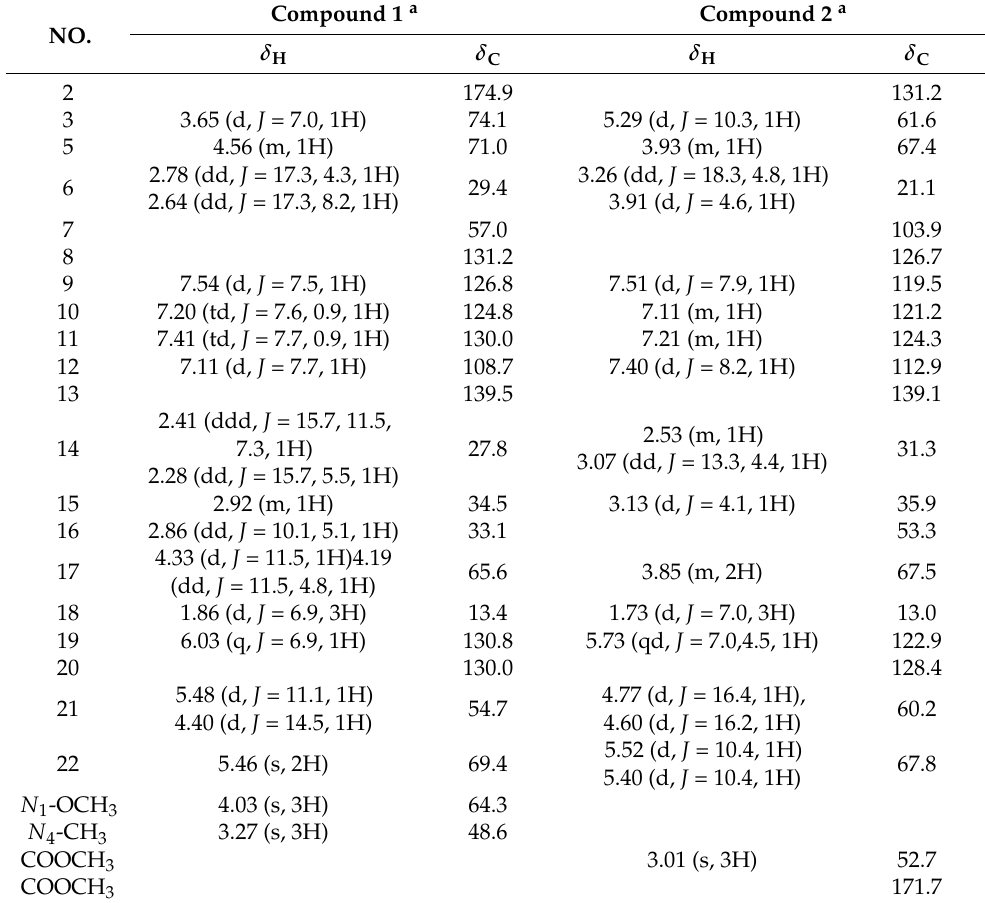
Table 1. 1 H (400 MHz) and 13 C NMR (100 MHz) data for compounds 1–2 ( δ in ppm, J in